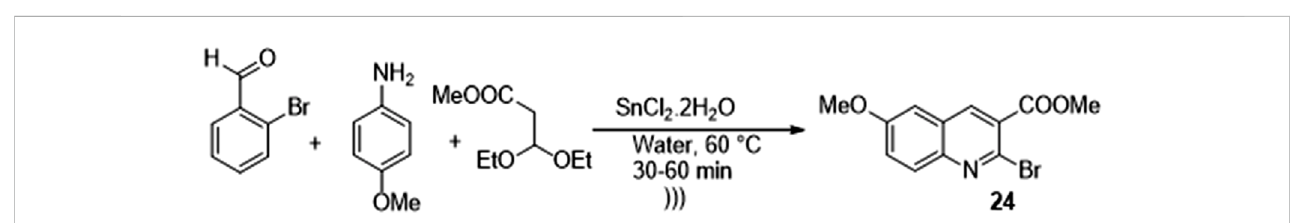
SCHEME 8 Ultrasound-assisted synthesis of 2-substituted quinolones.